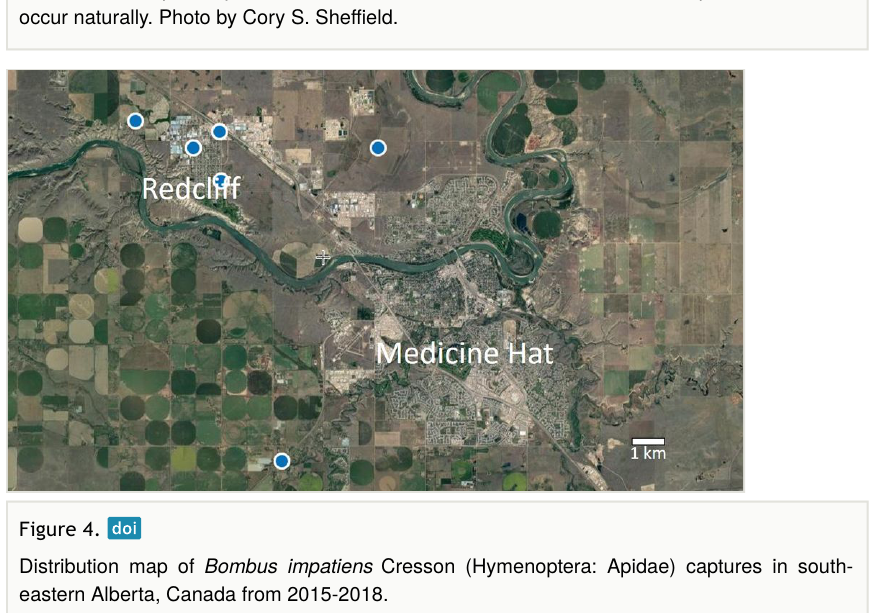
Several bumble bee species have declined in abundance in North America (Grixti et al. 2009), including Canada (Colla and Packer 2008, Colla et al. 2012, She ffi eld et al. 2016). National conservation status assessments by the Committee on the Status of Endangered Wildlife in Canada (COSEWIC) for Bombus occidentalis Greene (COSEWIC 2014a) and its sister species, B. terricola (COSEWIC 2015), have indicated that declines for these species have been mostly limited to southern British Columbia and eastern Canada, respectively, with declines not supported in most of the Canadian prairies where both species co-occur